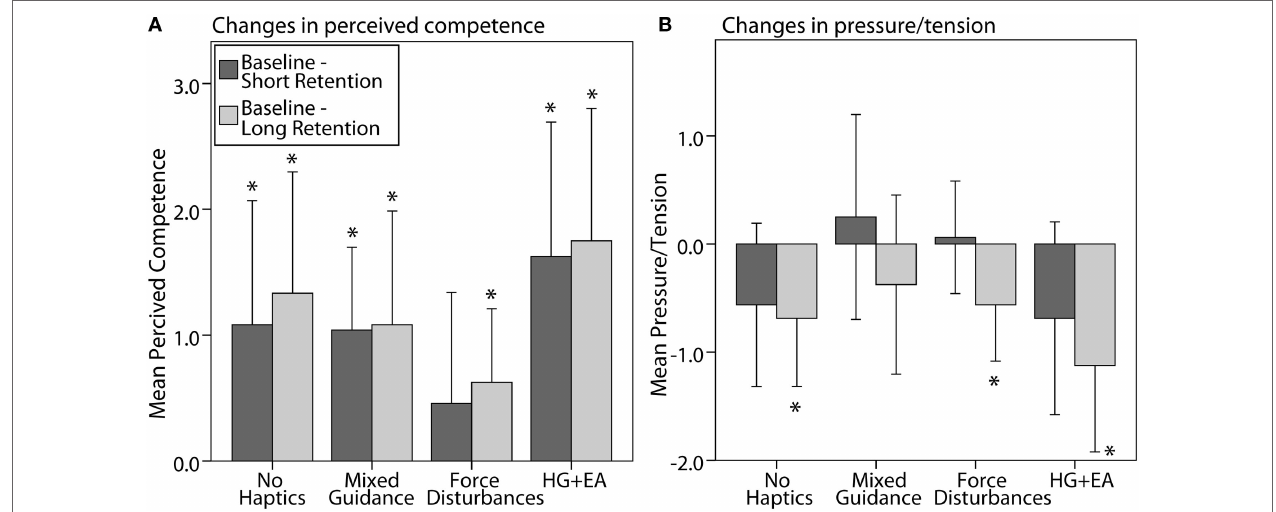
FIGURE 12 | Change in responses at short-term retention (dark gray) and after 3–5days, at long-term retention (light gray) . (A) Mean responses to Q2, Q6, and Q10 ( Table 1 ), related to perceived competence. (B) Mean responses to Q3, Q7, and Q11 ( Table 1 ) related to tension and pressure. All values are referred to the responses provided after baseline. * p < 0.05. Error bars: 95%